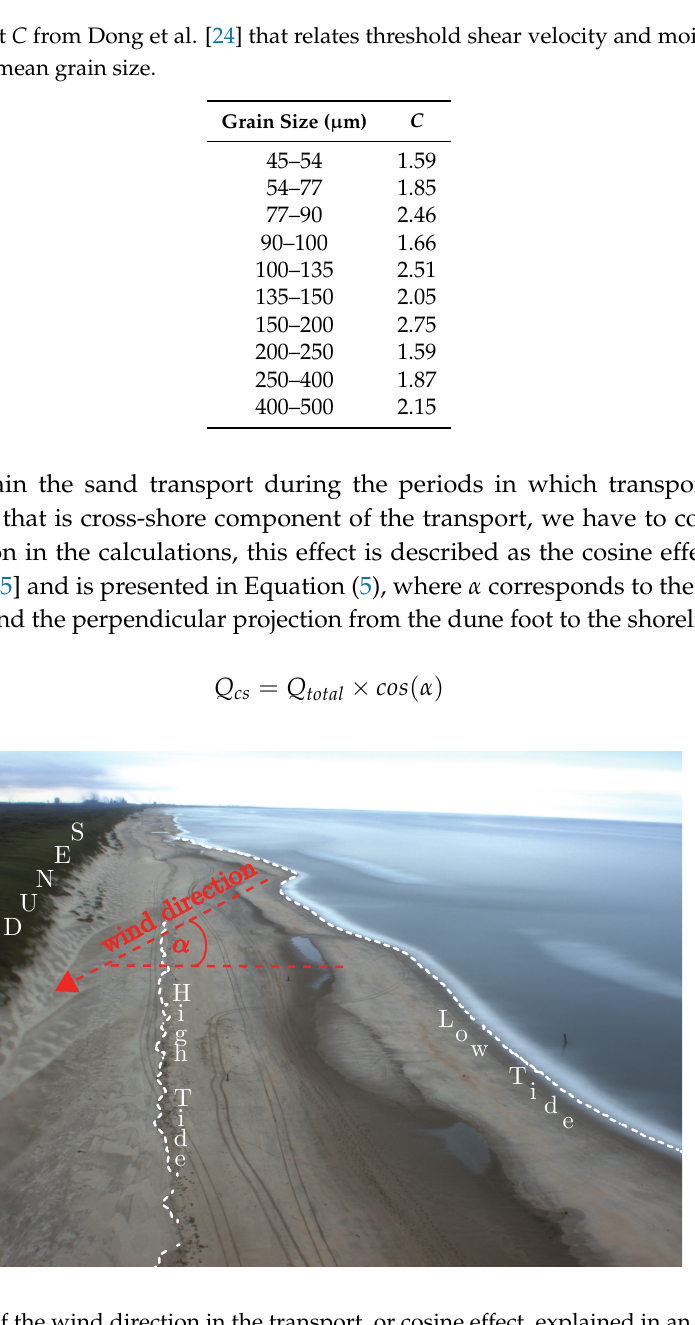
Figure 2. Effect of the wind direction in the transport, or cosine effect, explained in an Argus image. Where α is the angle formed by the wind direction and the perpendicular projection from the dune foot to the